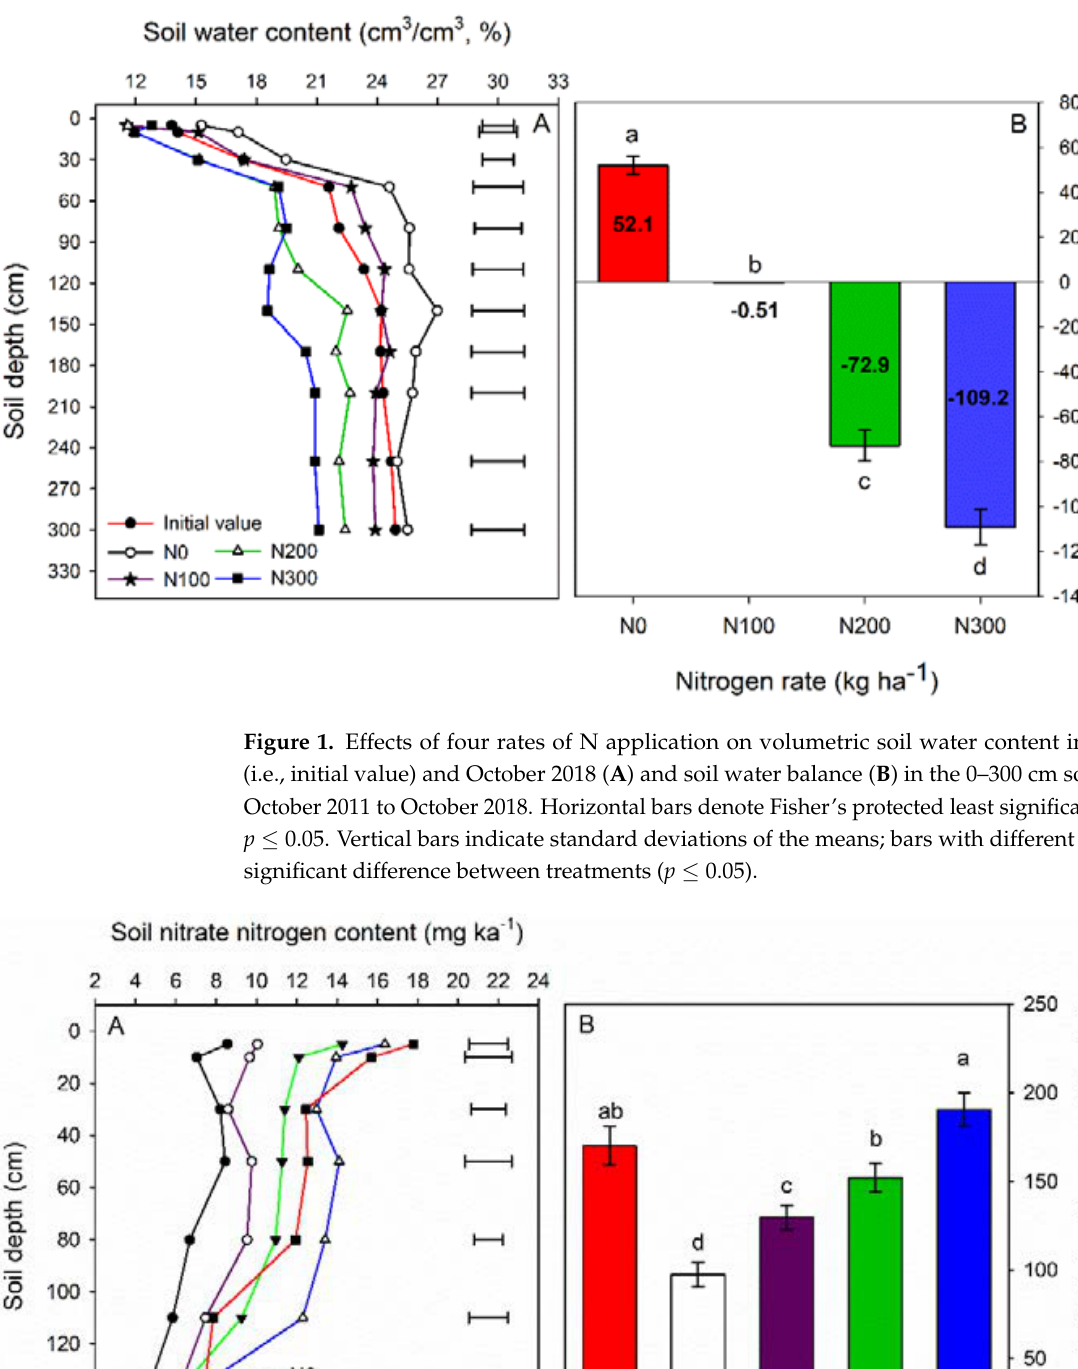
Figure 1. Effects of four rates of N application on volumetric soil water content in October 2011 (i.e., initial value) and October 2018 ( A ) and soil water balance ( B ) in the 0–300 cm soil depths from Oc- tober 2011 to October 2018. Horizontal bars denote Fisher’s protected least significant difference at p ≤ 0.05. Vertical bars indicate standard deviations of the means ; bars with different letters indicate significant difference between treatments ( p ≤ 0.05).